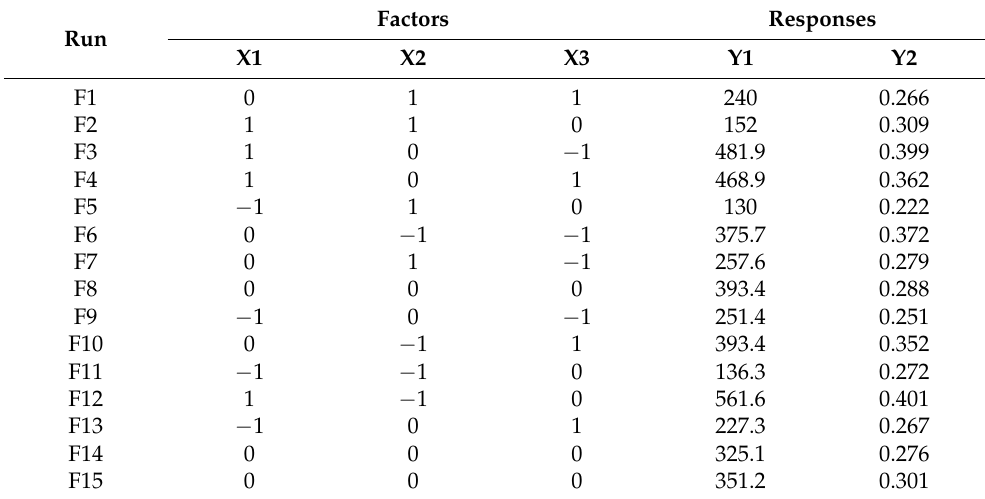
Table 4. Design of experiment for Box–Behnken method with 15 trial runs with results of responses. Factors Responses Run